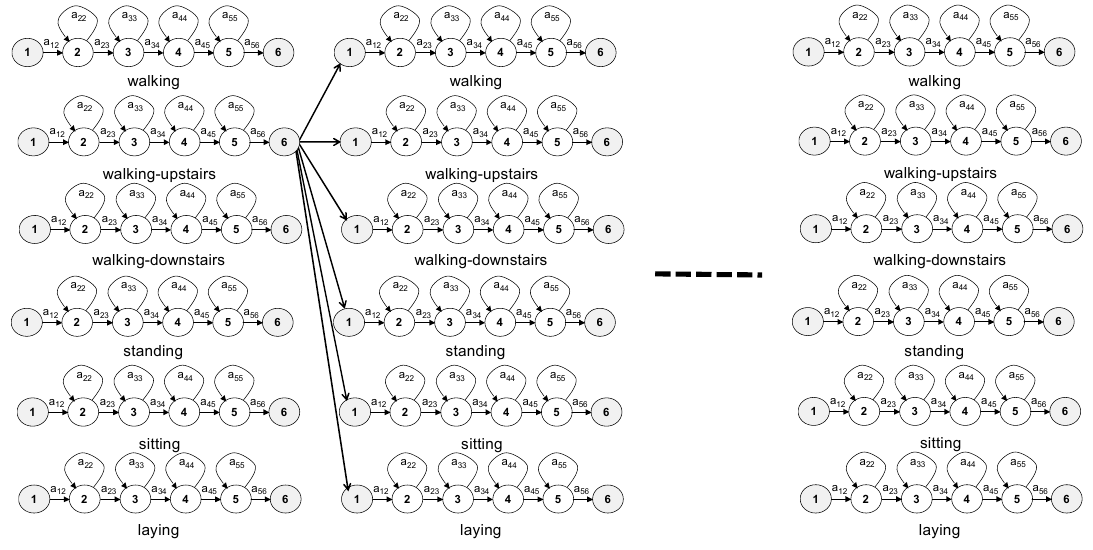
Figure 3. Search space for activity segmentation.